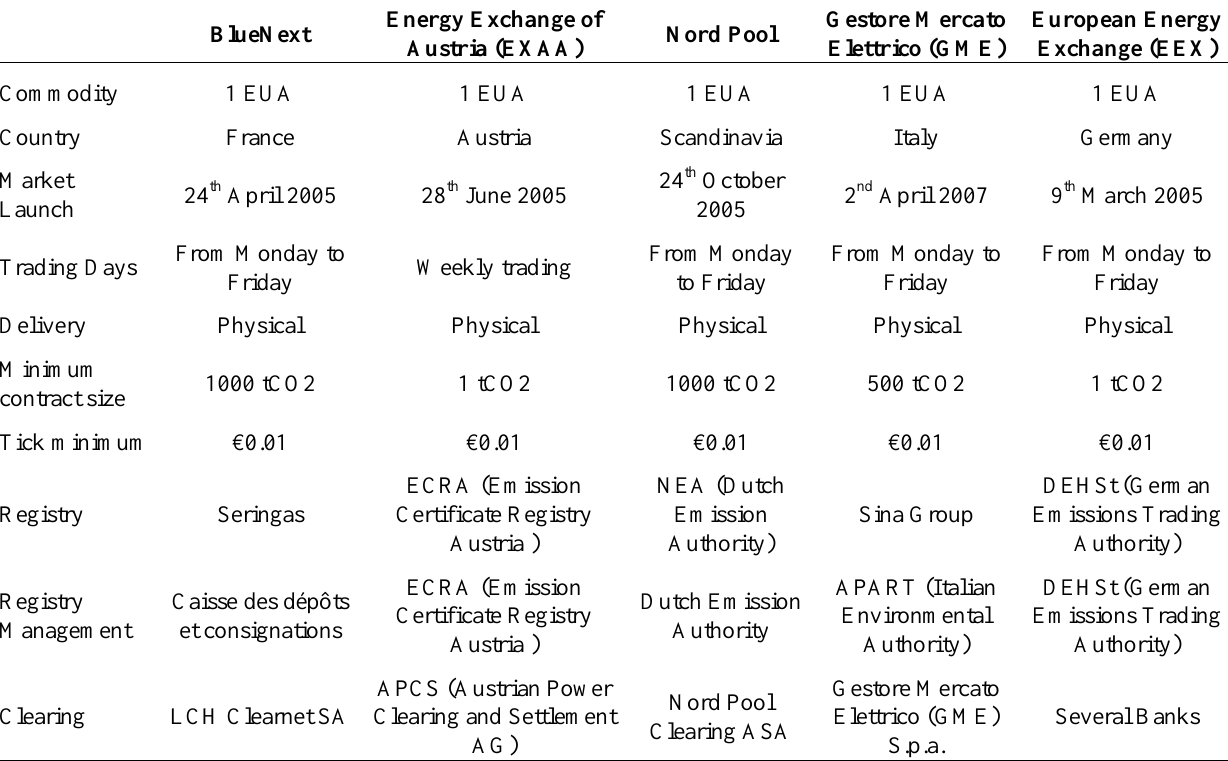
Table 3. Spot Trading Rules Details in Organized Markets for Phase I